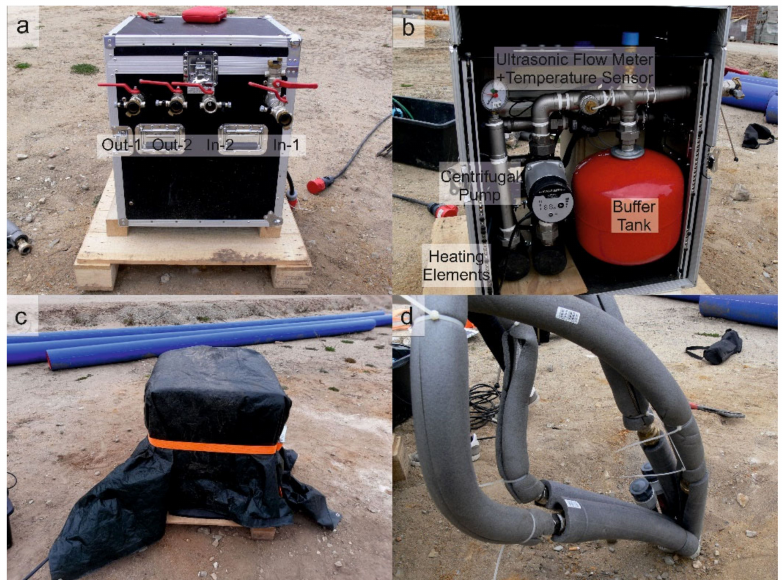
Figure 2. Compact TRT device on site preparations; ( a ) main and secondary circuits with taps and filler pieces; ( b ) components: heating devices with 6 kW and 3 kW, centrifugal pump with adjustable flow setting options, ultra-sonic flow meter (black), temperature sensor of return pipe, and buffer tank; ( c ) insulation (not visible), additional weather coverage, and insulation mats below the device; ( d ) insulation hoses for steel tubes and subsurface BHE parts. Connections were insulated after